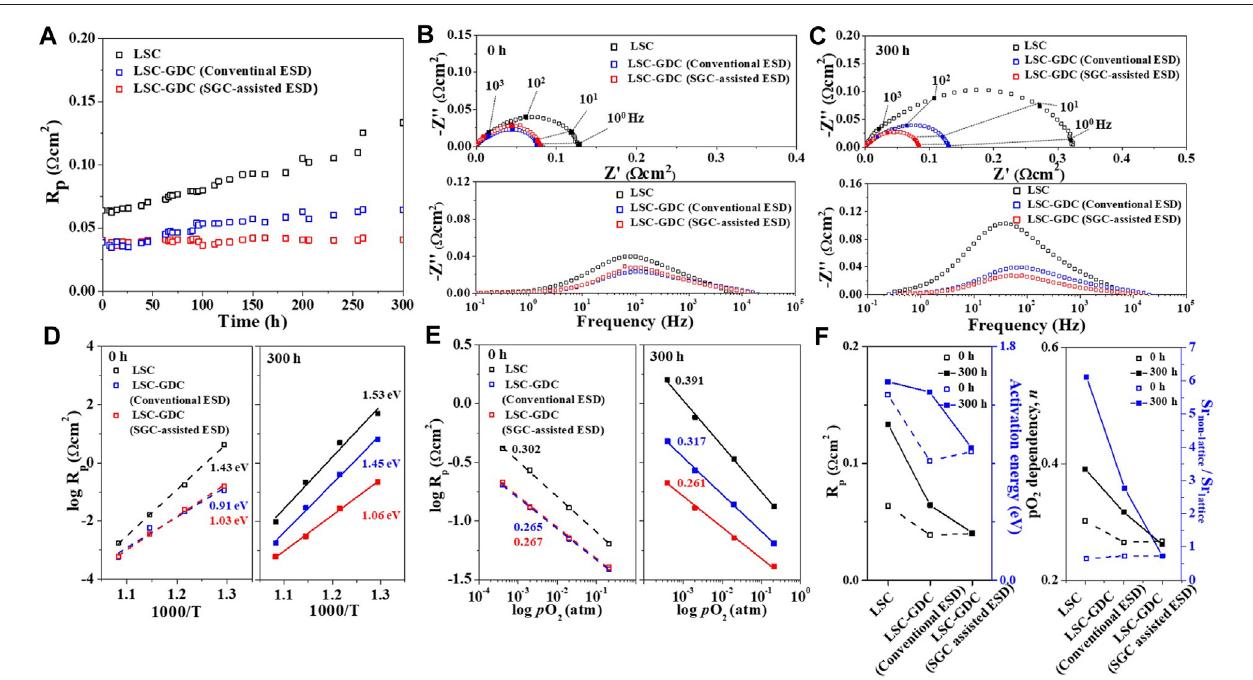
FIGURE5| ElectrochemicalevaluationoftheLSCelectrodeandLSC-GDCelectrodesfabricatedbytheconventionalESDandSGC-assistedESD. (A) Polarization resistance with respect to time for 300 h at 650 ° C. Nyquist and Bode plots at (B) 0 h and (C) 300 h. (D) Arrhenius plots at 0 and 300 h. (E) Polarization resistance as a function of oxygen partial pressure at 650 ° C. (F) Polarization resistance, activation energy, p O 2 dependency n , and Sr non-lattice /Sr lattice ratio for the three electrodes.